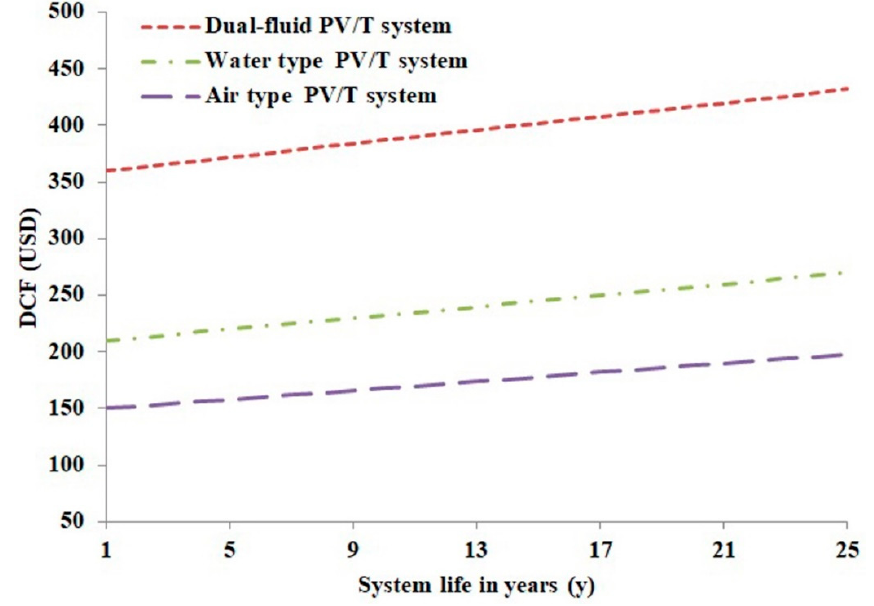
Figure 10. Variations of the discounted cash flow (DCF) of the PV/T systems across 25 years.